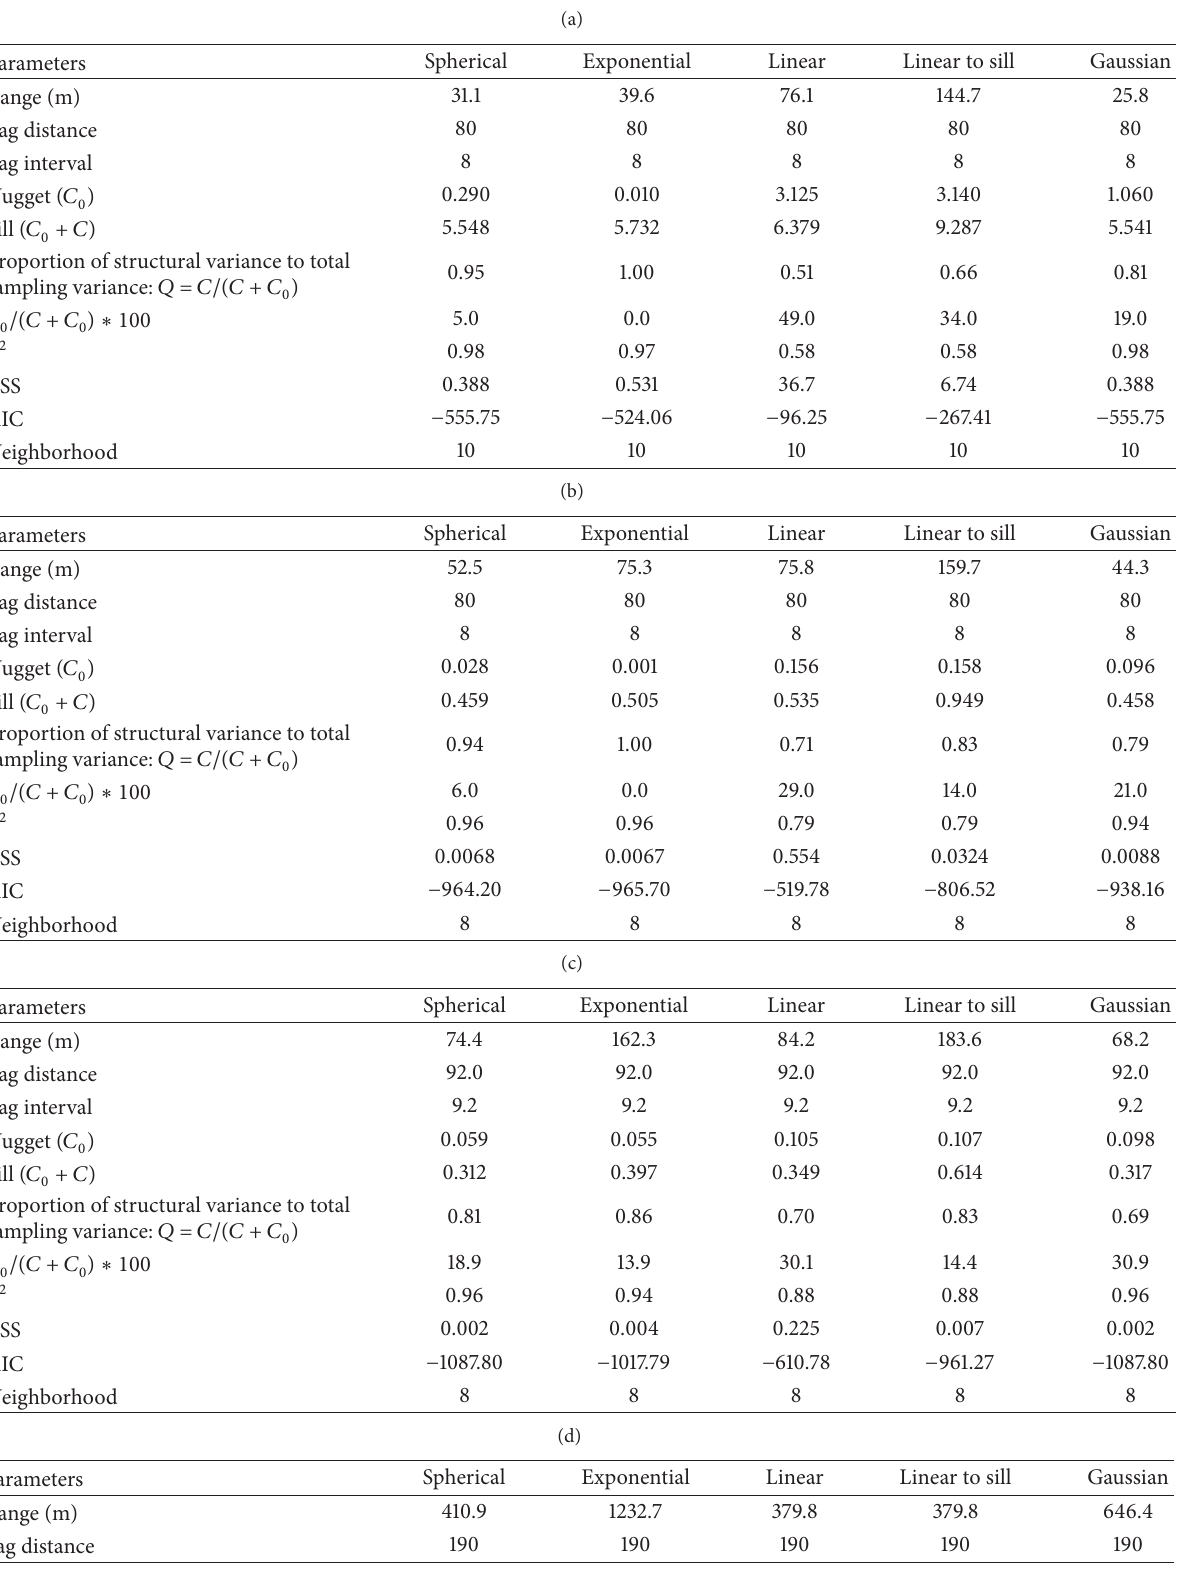
Table 4: (a) Comparison of variogram models for soil As. (b) Comparison of variogram models for straw As. (c) Comparison of variogram models for husk As. (d) Comparison of variogram models for grain